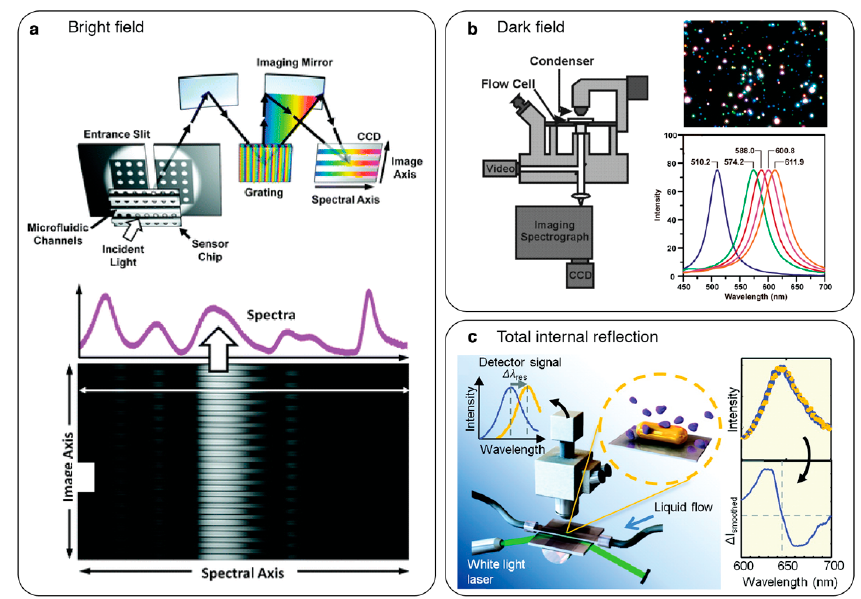
Figure 3. Imaging spectroscopy-based one-dimensional (1D) spatial optical interrogation of nanophotonic sensors. ( a ) (top) Bright-field transmission configuration used to interrogate plasmonic Ag nanohole arrays for real-time multiplexed affinity measurements. (bottom) An exemplary image showing spectra corresponding to the sensor area imaged through the entrance slit. Reproduced from [55] with permission from The Royal Society of Chemistry; ( b ) (left) Dark-field transmission configuration used to interrogate single Ag nanoparticles in real-time with zeptomole sensitivity. (right) Dark field image of nanoparticles and their spectra showing resonance peak shift as the top media refractive index changes. Reproduced from [61] and [58]. Copyright 2003 Society of Photo-Optical Instrumentation Engineers (SPIE) and Copyright 2005 American Chemical Society; ( c ) Total internal reflection setup to interrogate individual plasmonic nanoparticles for time-resolved single protein detection with minimal background interference. Spectral changes in the resonance peak showing the molecule binding events. Adapted with permission from [63]. Copyright 2012 American Chemical Society.